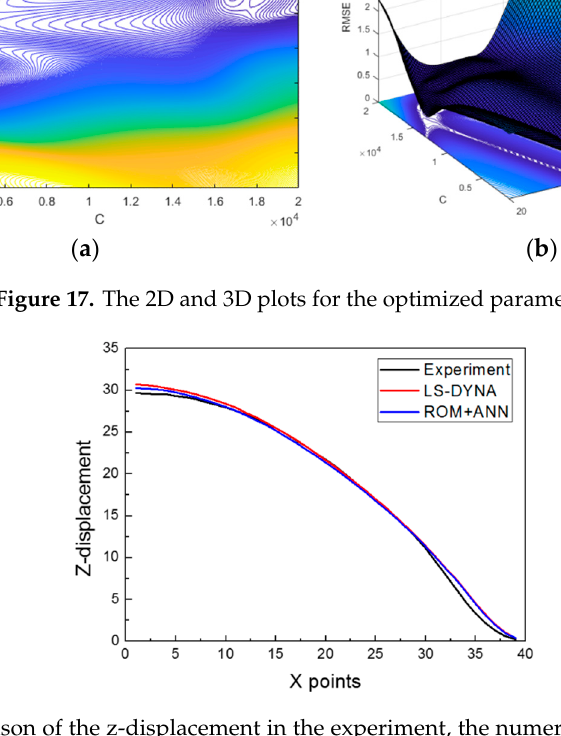
Figure 18. Comparison of the z-displacement in the experiment, the numerical simulation, and the surrogate model at optimized parameters. Table 3. Numerical validation of the experiment, the numerical simulation, and the surrogate model.